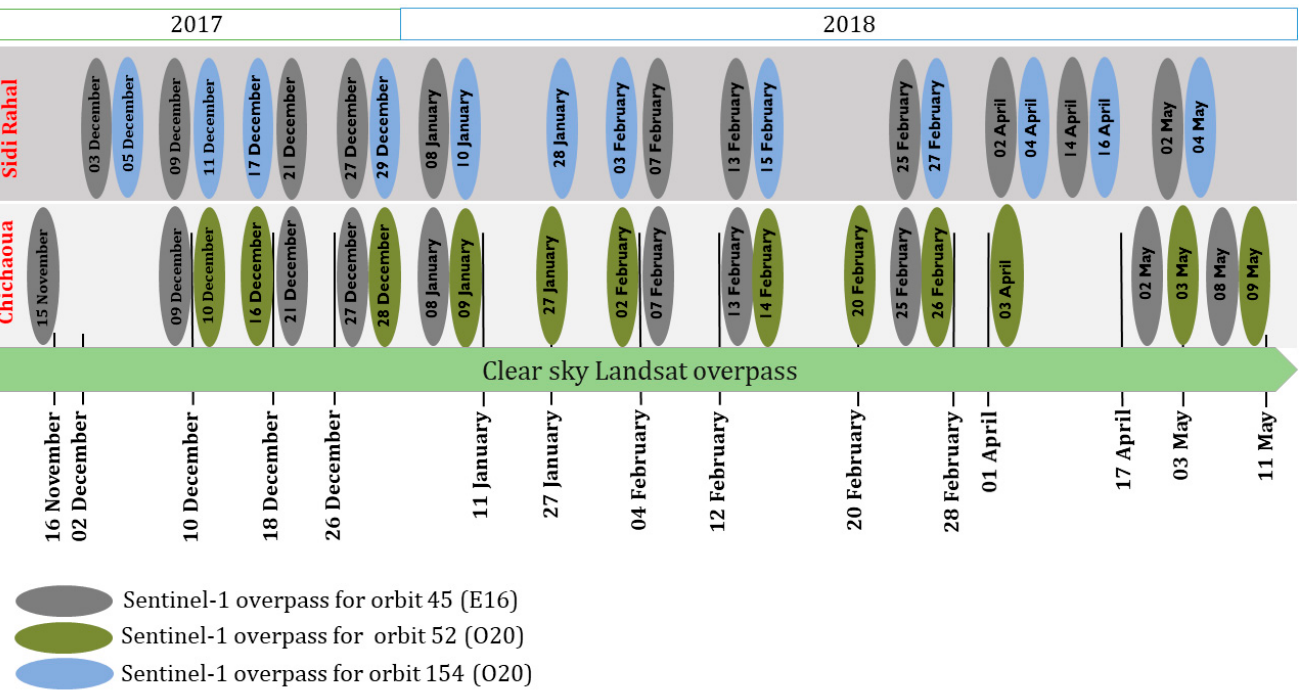
Figure 2. Dates of the Sentinel-1 and clear sky Landsat-7/8 overpasses for both the Chichaoua and Sidi Rahal sites.